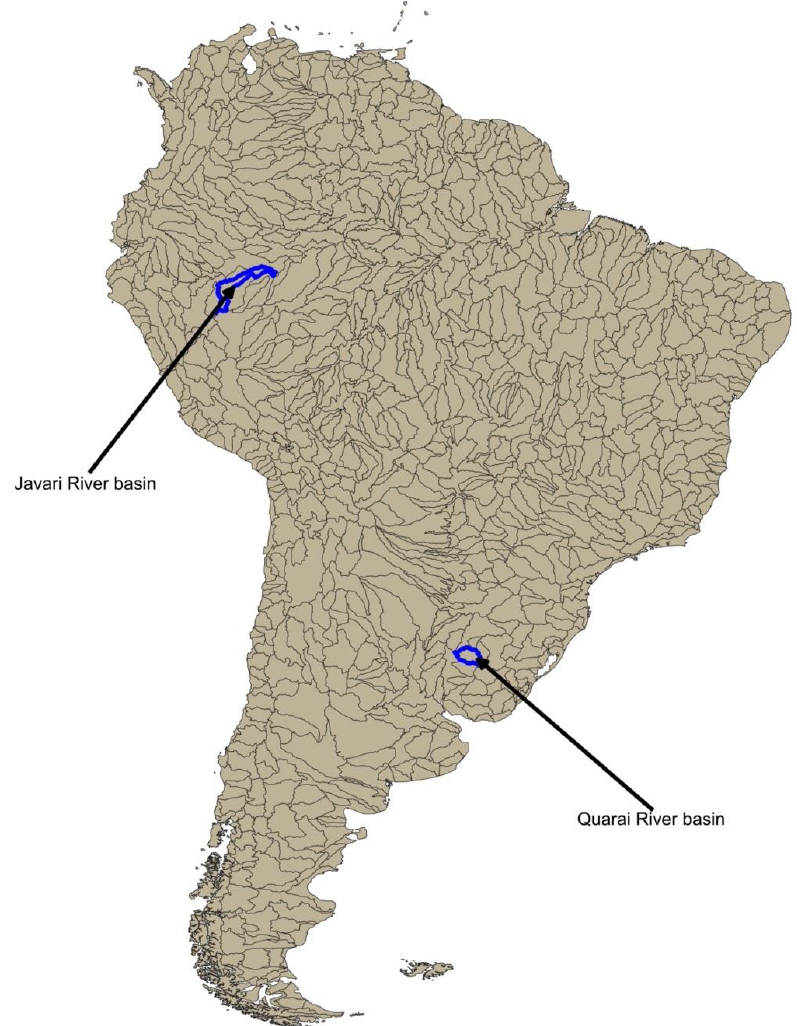
Figure 13. Basins and sub-basins available at Aquamaps (FAO).